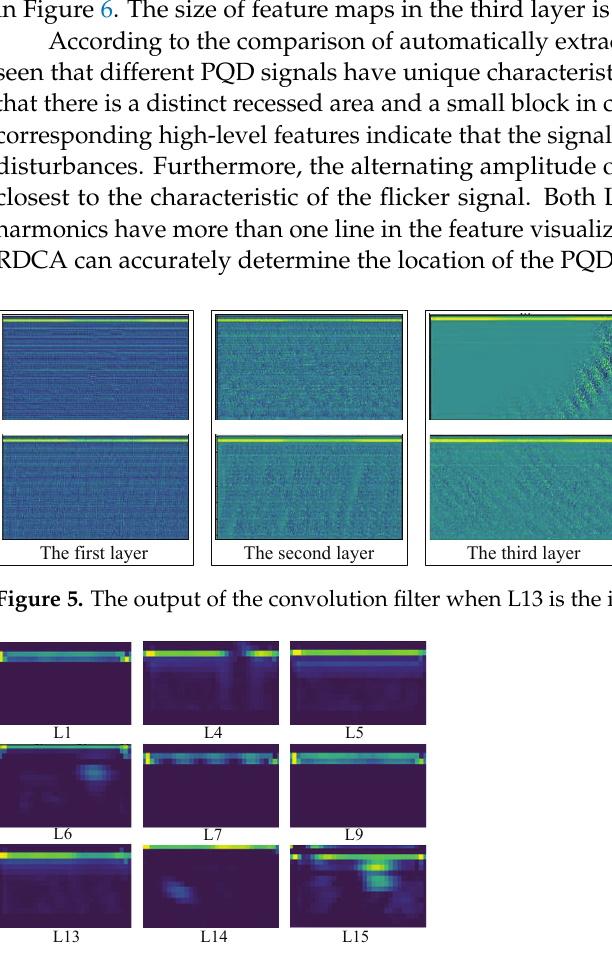
Figure 6. The feature visualization of the third layer in